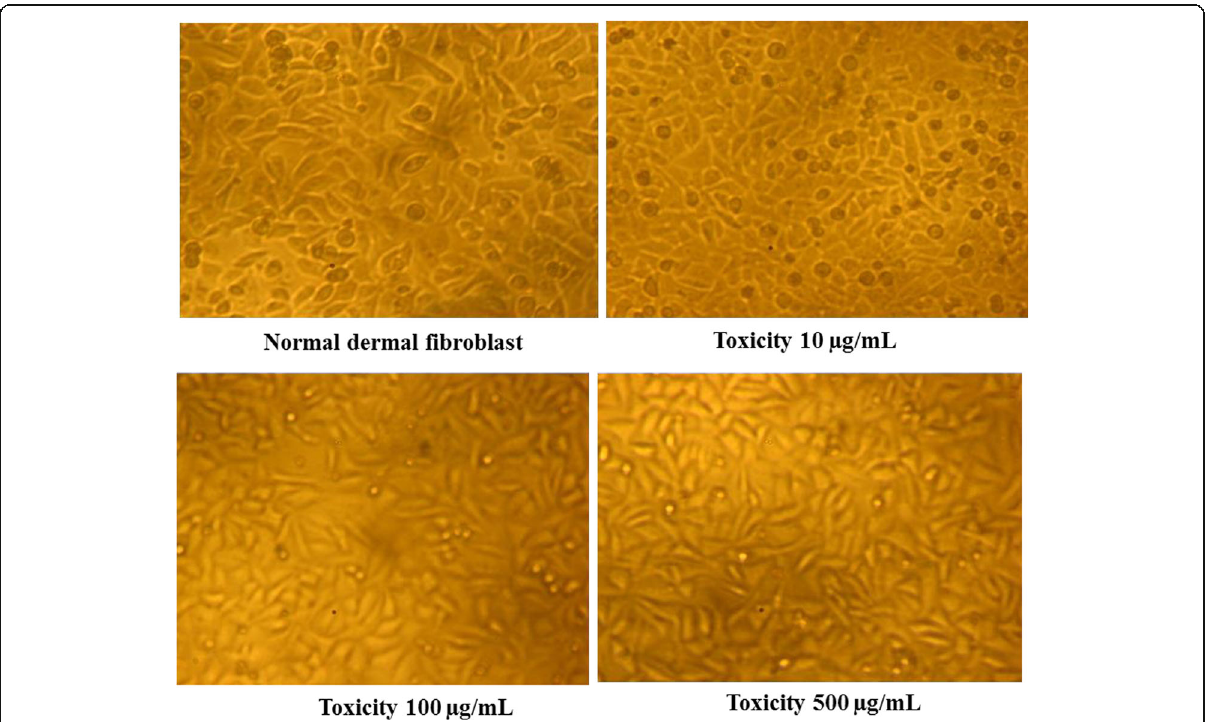
Fig 8 Microscopic image of cytotoxicity tests of human dermal fibroblast with the root extracts of S. heyneanus